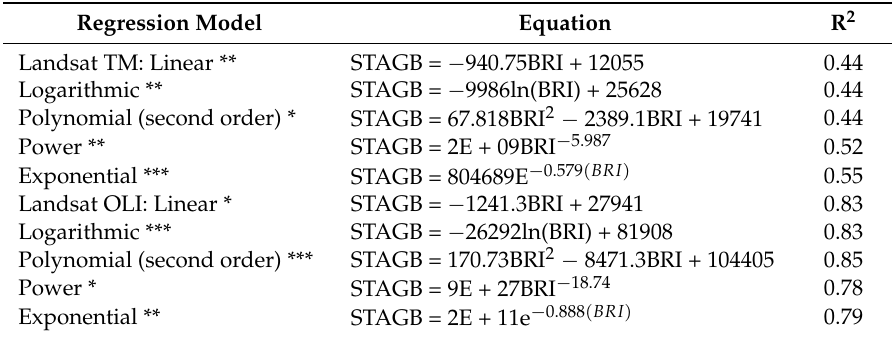
Table 12. Regression models of STAGB versus BRI derived with TM and